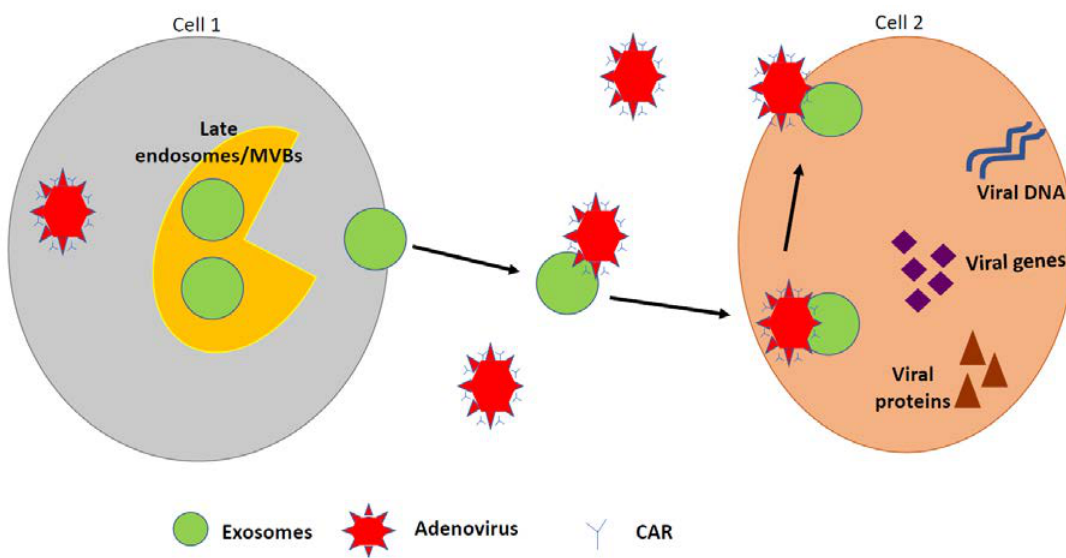
Figure 3. Exosomes mediate HAdV attachment and entry. The coxsackie and adenovirus receptor (CAR) mediates the entry of HAdv into human cells. Exosomes act as carriers for viruses, and this inclusion is important for viral survival, spread, and infection in the host organism. The HAdV binds to exosomes, enters cells via phosphatidylserine / TIM-4 interactions or other binding proteins. In addition, the virus injects their DNA into the host cell, which produces copies of its genes and proteins, resulting in transmission. Multivesicular bodies